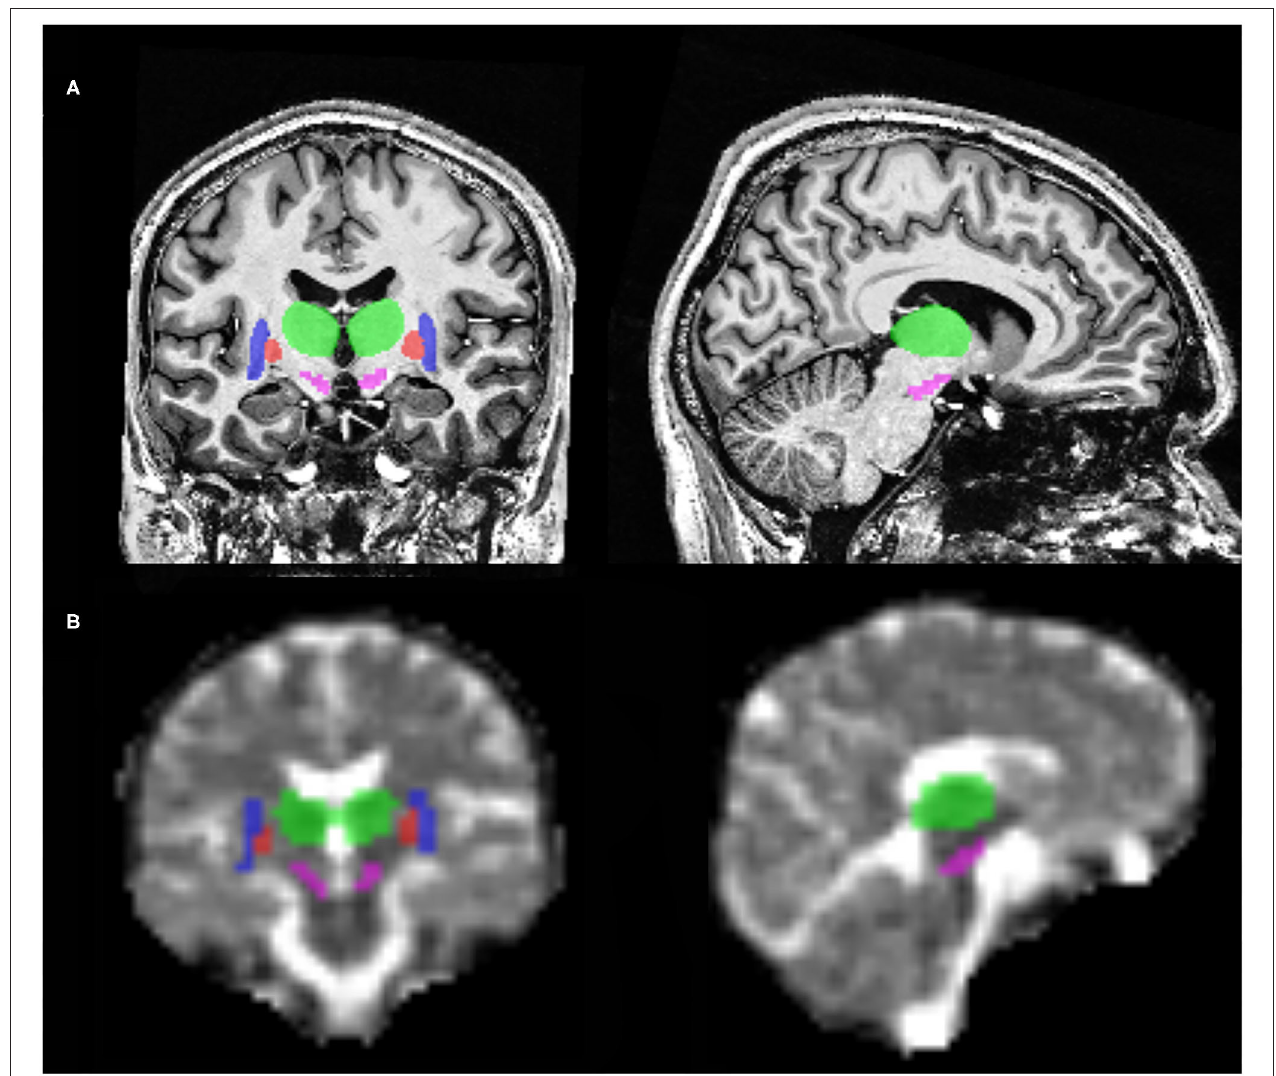
FIGURE 1 | Illustration of regions of interest with coronal and sagittal brain MRI slices at 7T. (A) 1 H T1-weighted MP2RAGE slices. (B) 23 Na MRI slices. In this illustration, can be seen the substantia nigra (pink), putamen (blue), pallidum (red) and the thalamus (green).